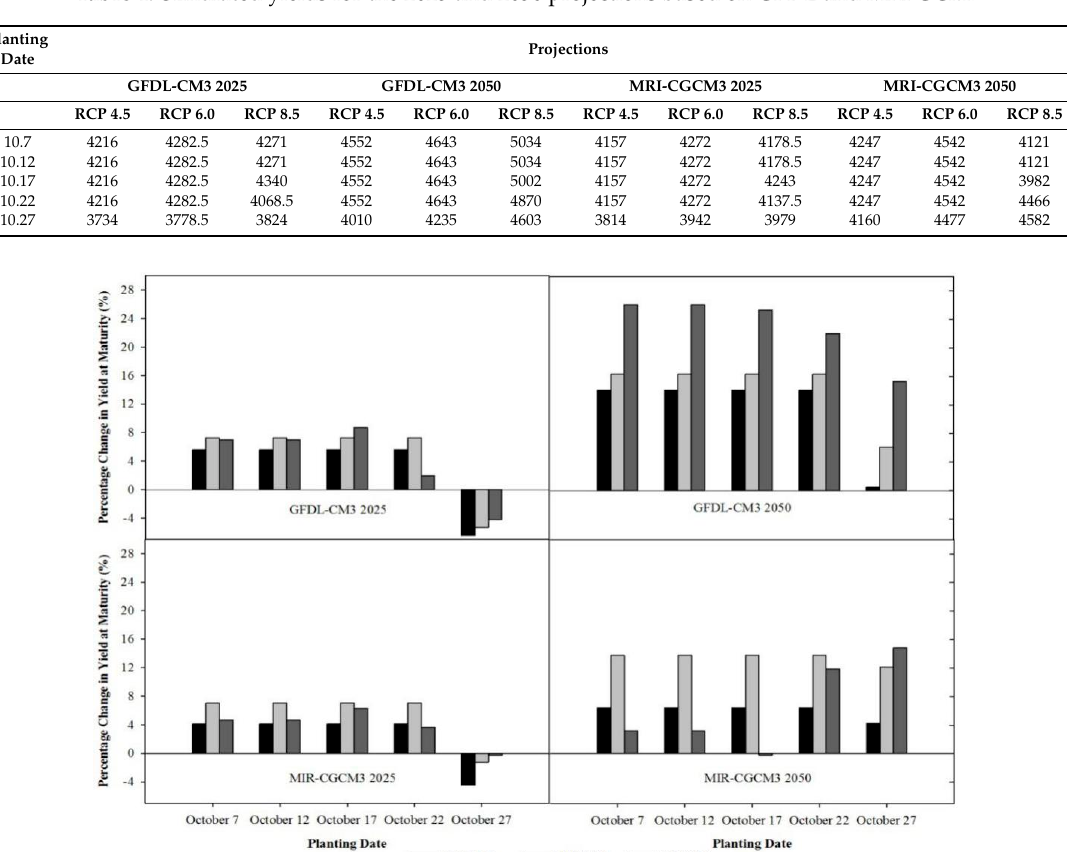
Figure 7. Predicted winter wheat yield for Guanzhong Plain based on three RCPs under changed planting dates based on two GCMs in the 2025 and 2050 projections.